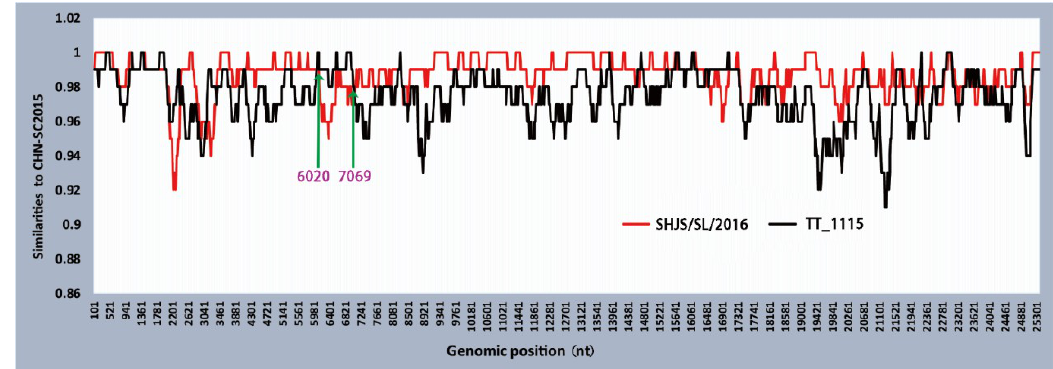
Figure 7. Recombination analysis of the complete genome of PDCoV strain CHN-SC2015. Potential recombination events were identified using Recombination Detection Program 4 (RDP4) and then examined using similarity plots and bootstrap analysis in Simplot 3.5.1. in the case of p -values less than 10 − 8 . Major and minor parents are represented by red and black, respectively. The green arrows indicate the recombination breakpoints.